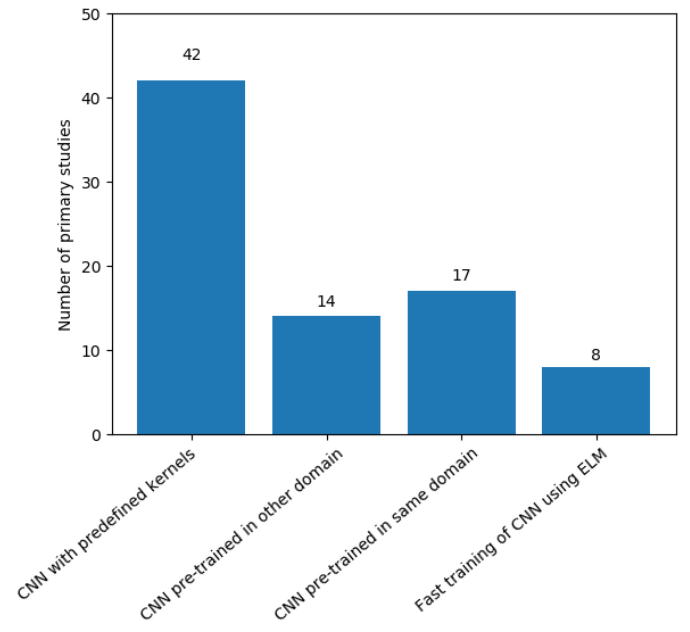
Figure 5. The types of CELM architecture proposed in the literature and the number of primary